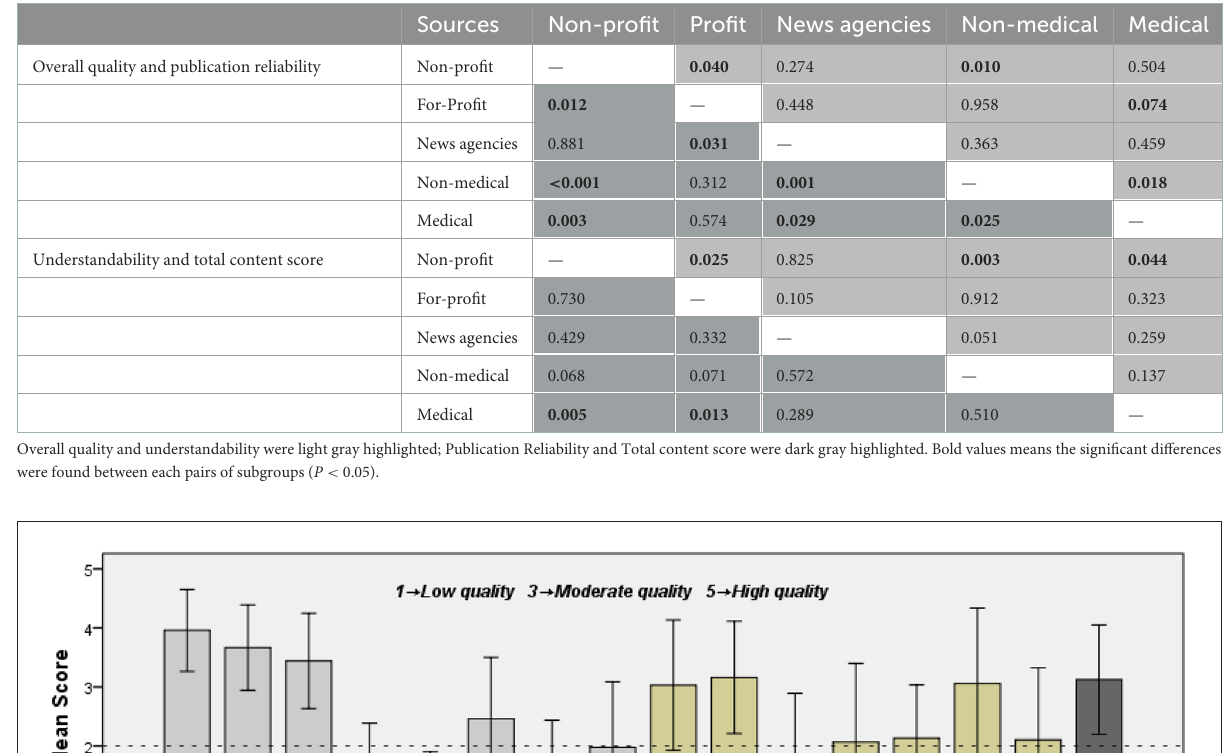
TABLE 4 The post-hoc analysis for exploring the underlying differences between video sources.